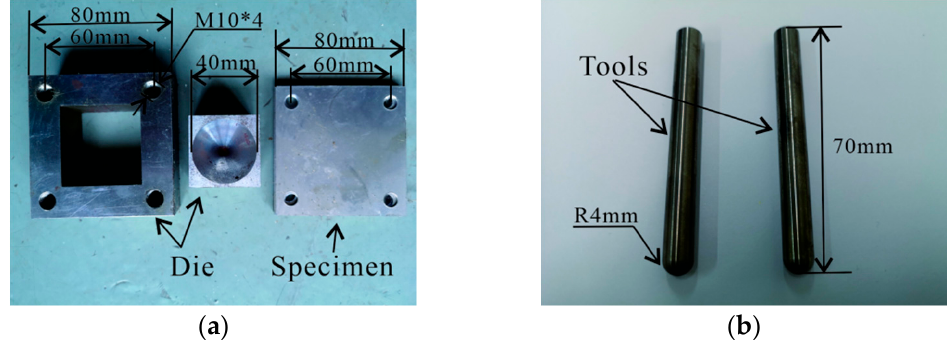
Figure 1. Devices for incremental forming. ( a ) Specimen and die. ( b ) Forming